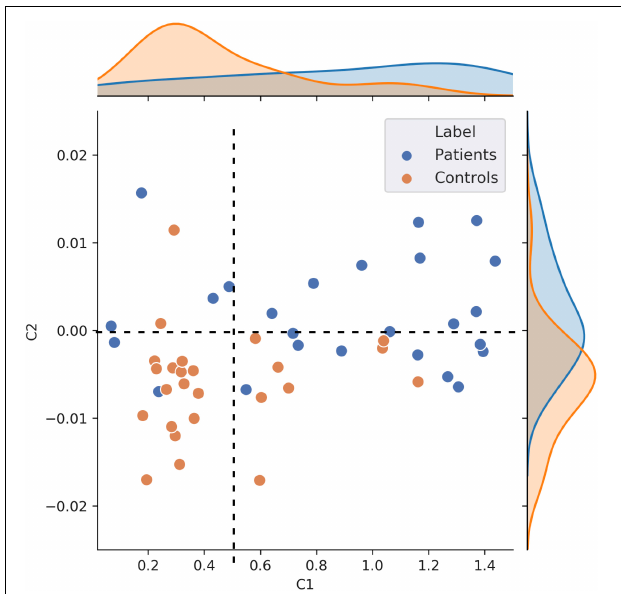
FIGURE 5 | Scatter plot visualization of individual C1 and C2 values. This figure shows individual C1 and C2 values, averaged across all the nodes that showed statistically significant patient vs. controls decoding ( n = 50). This scatter plot illustrates that patients exhibit overall higher self-similarity (higher C1) and less multifractality (higher, less negative, C2).